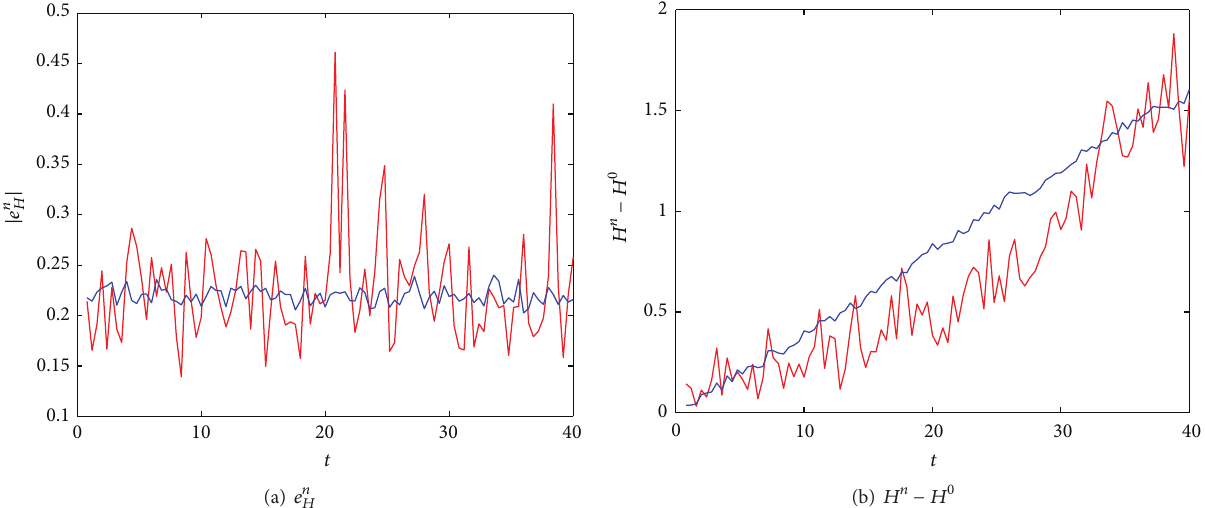
Figure 6: Residuals of discrete energy for one trajectory and the average energy over 50 trajectories.